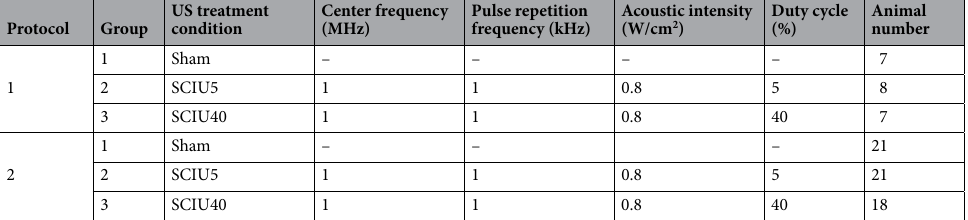
Table 2. Summary of the experimental ultrasound (US)